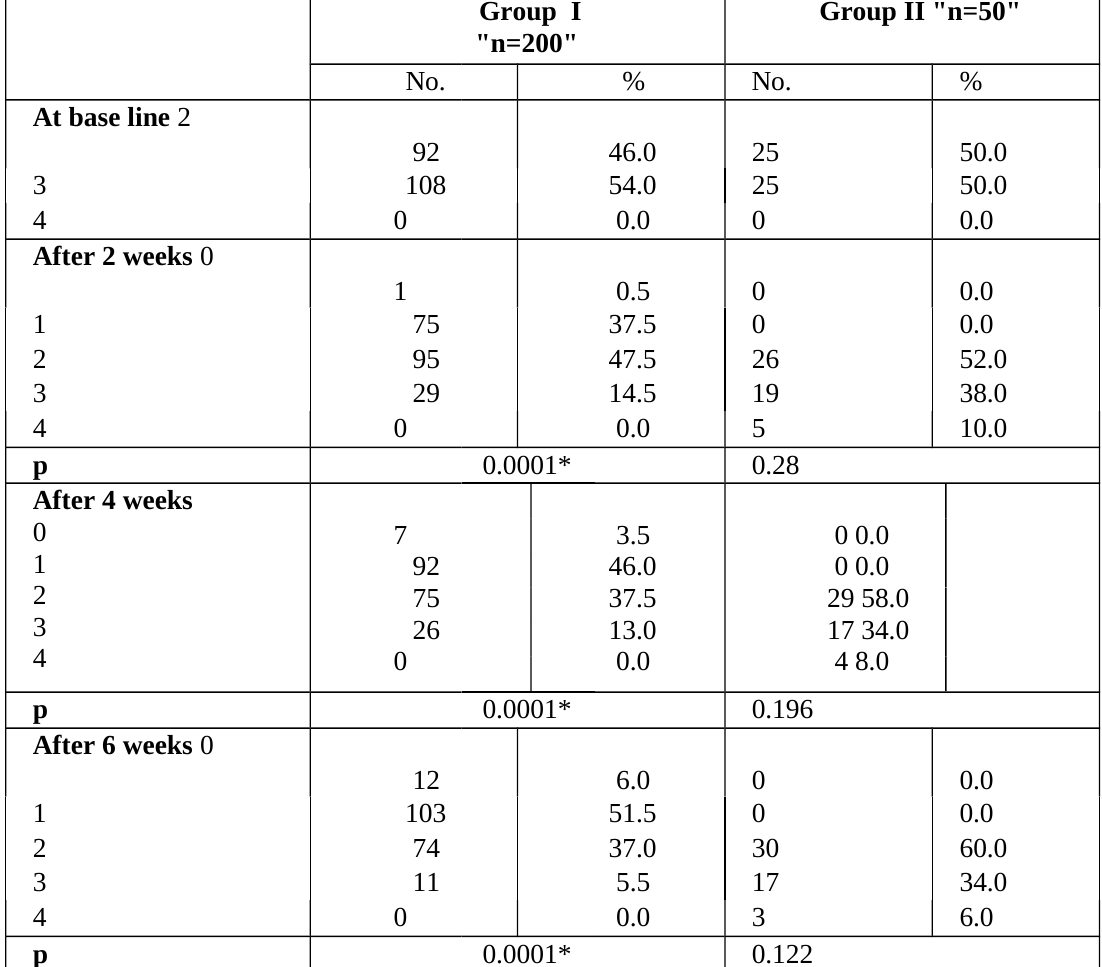
Table (7): Comparison between base line global acne assessment score and different period of follow up in the same group.